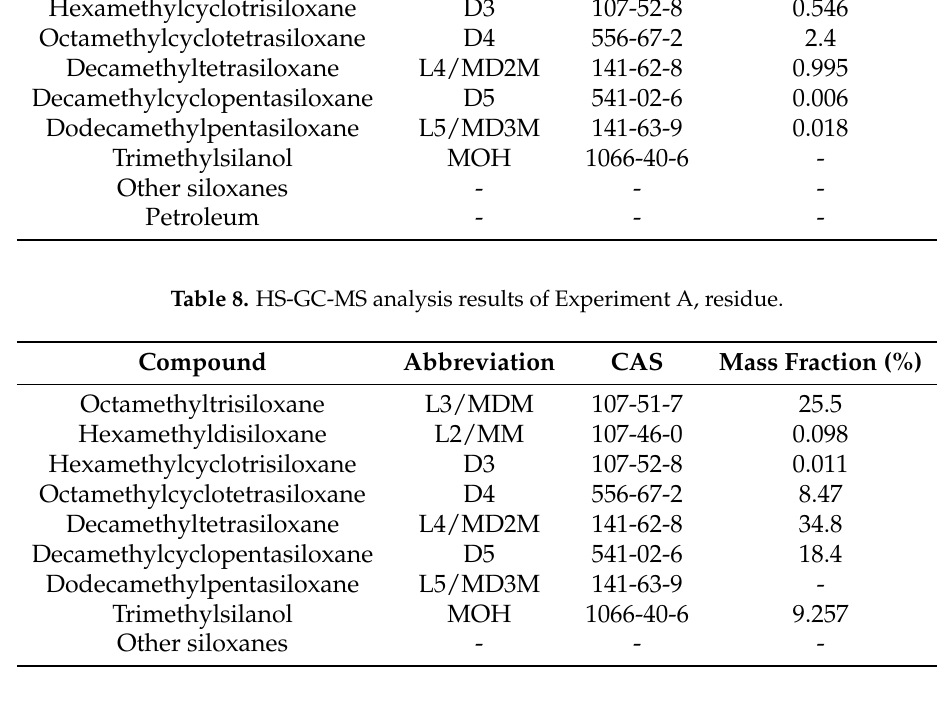
Table 9. HS-GC-MS analysis results of Experiment B, Product #1.